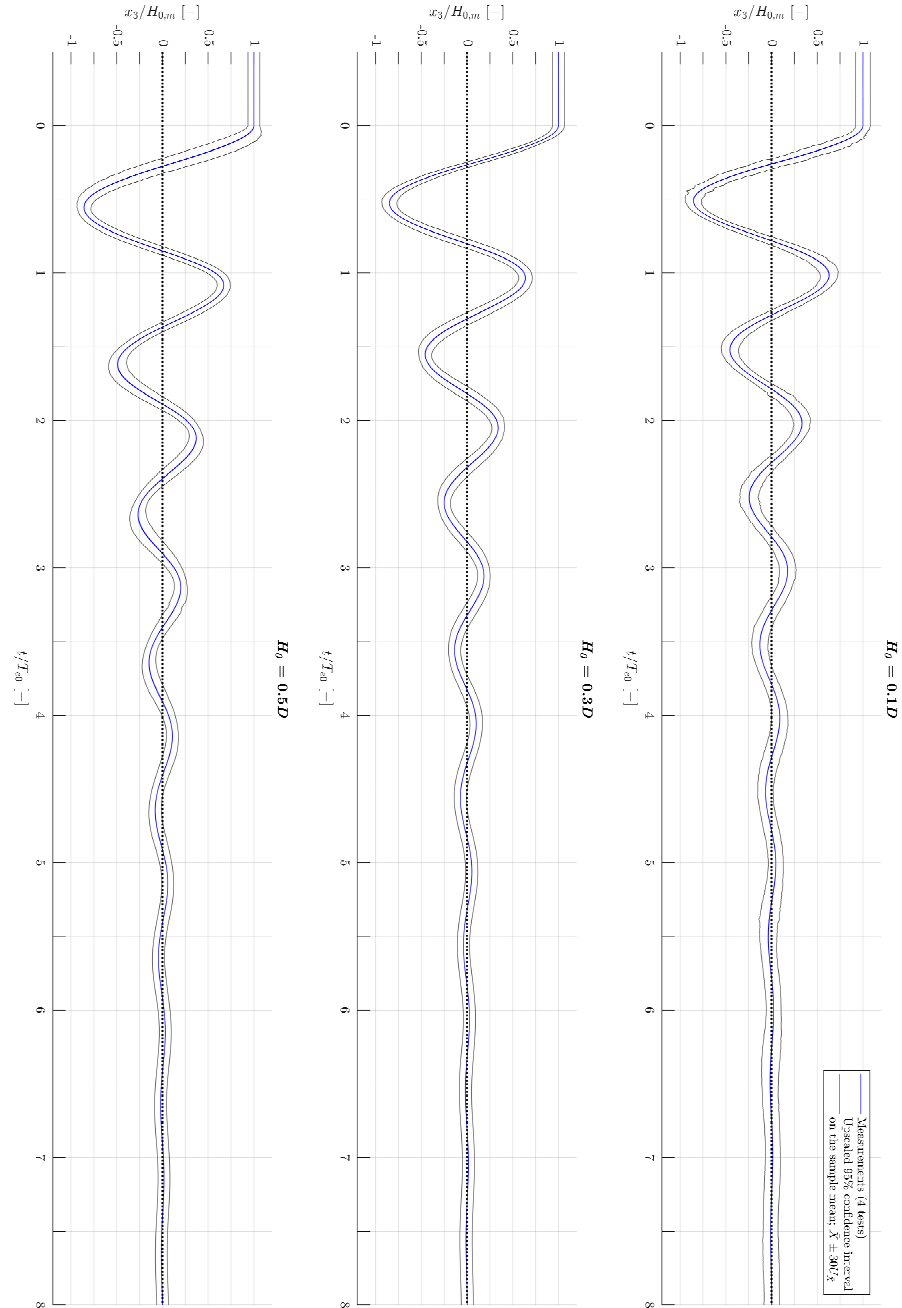
respectively. The measured surface elevation time series for the drop heights 𝐻 (cid:2868) = 0.1𝐷 and 𝐻 (cid:2868) = 0.3𝐷 are presented in Figure A9. The locations of wave gauges can be seen in Figure 8. The measured motions in all six DoF for the drop heights 𝐻 (cid:2868) = 0.1𝐷 and 𝐻 (cid:2868) = 0.3𝐷 are presented in Figures A10 and A11, respectively.